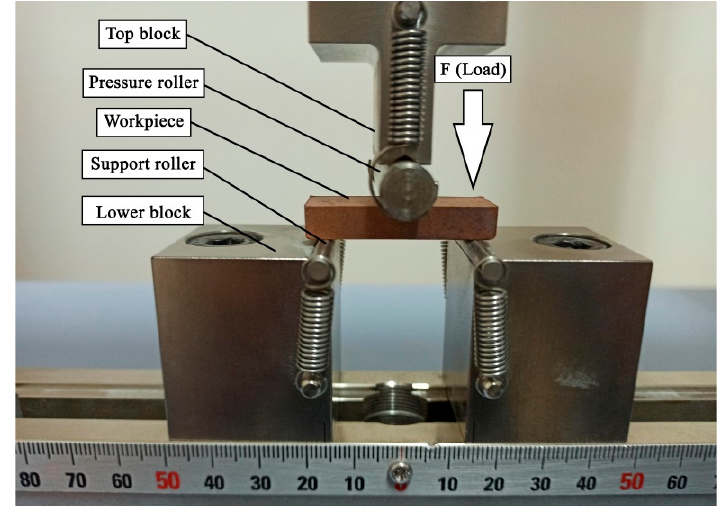
Figure 2. Image of C1 specimen during three-point bending test.